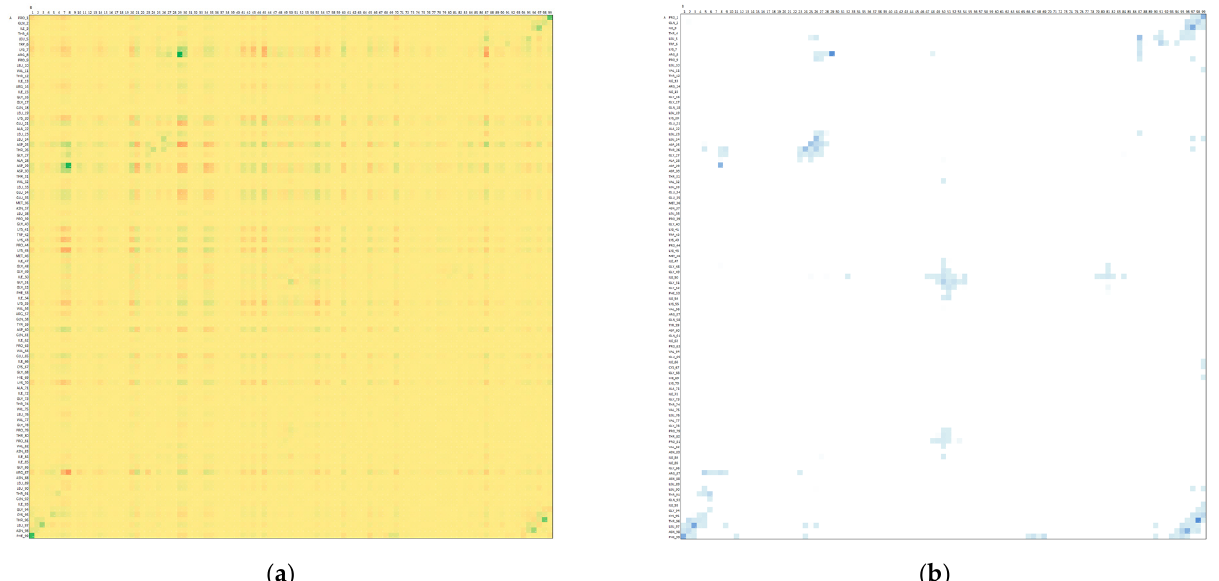
Figure 5. Heat plot for averaged electrostatic interaction energies ( a ) and penetration contributions to it ( b ) for the KZK structure. Scale for ( a ): from green to red, dark green—the most negative values, dark red—the most positive values, and yellow—close to zero values. Scale for ( b ): from blue to white, dark blue—the most positive values, and white—zero values.